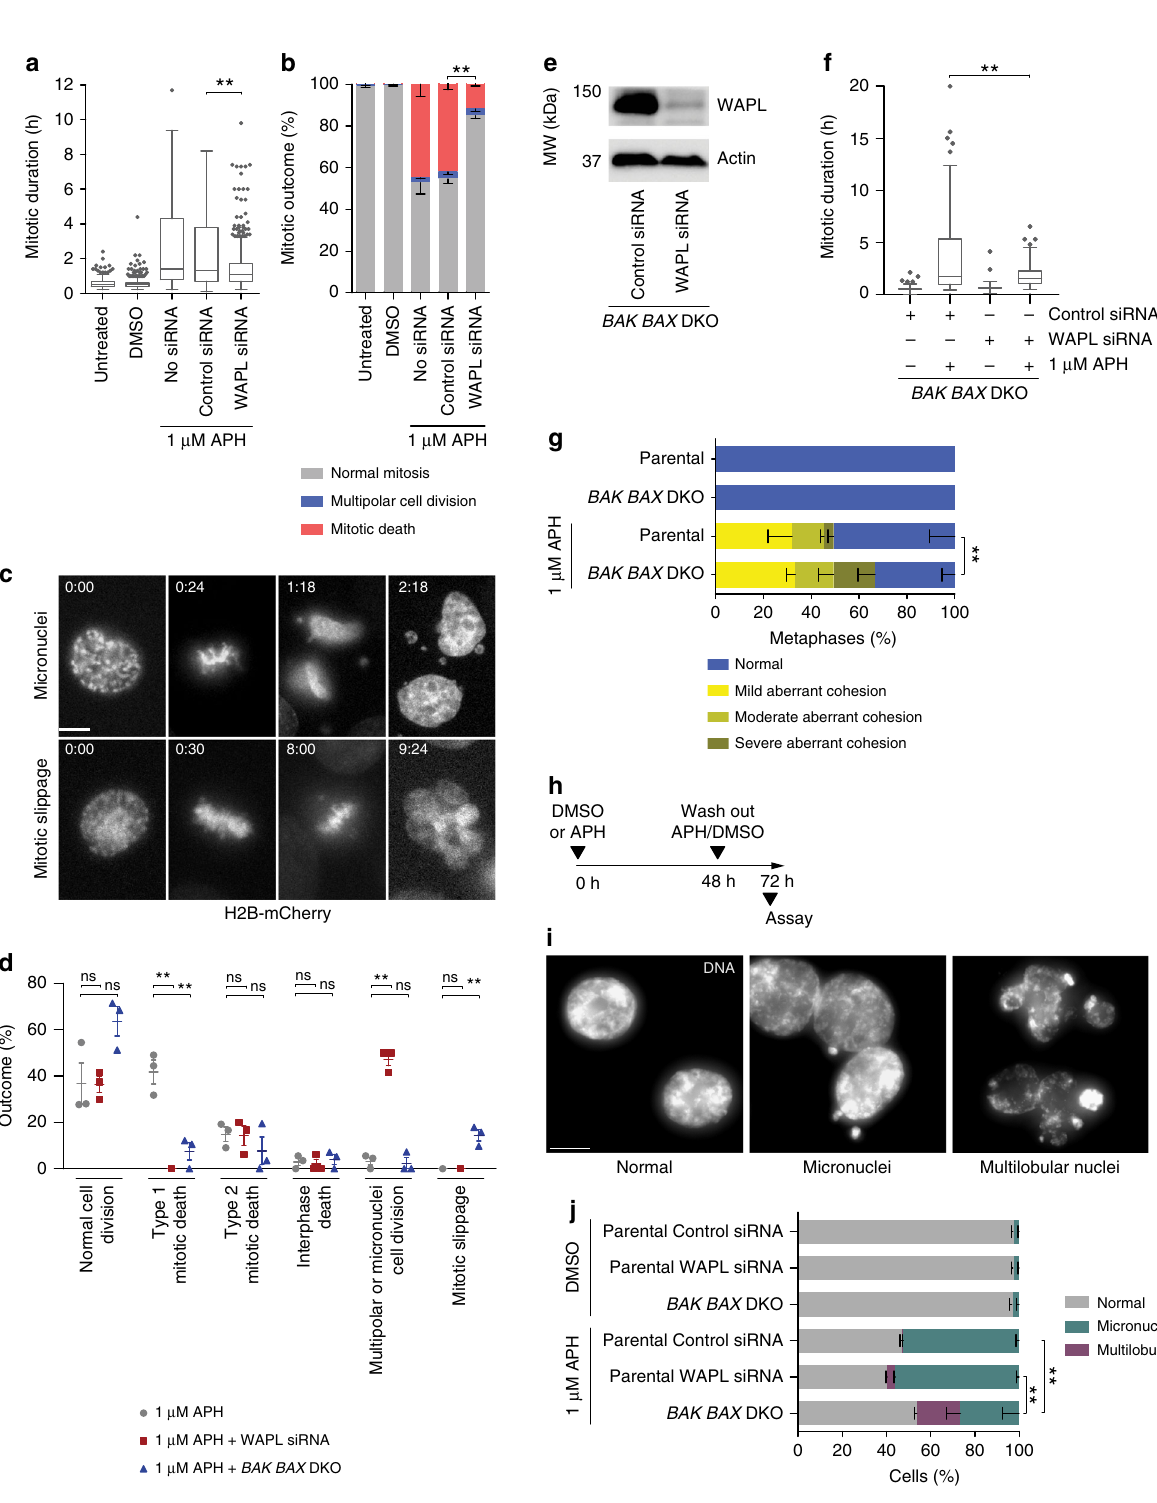
replication stress. One possibility is that exogenous replication stress disproportionally impacts the dif fi cult to replicate repetitive G-rich telomeric DNA sequence 27 – 29 . Replication stress in ver- tebrate telomeres is attenuated through the telomere-speci fi c TRF1 protein 29 . To investigate potential contribution of telomere replication stress to mitotic lethality, we over-expressed mCherry-TRF1 (mCherry-TRF1 OE ) in HT1080 6TG cells (Fig. 6d). Surprisingly, mCherry-TRF1 OE failed to reduce the number of